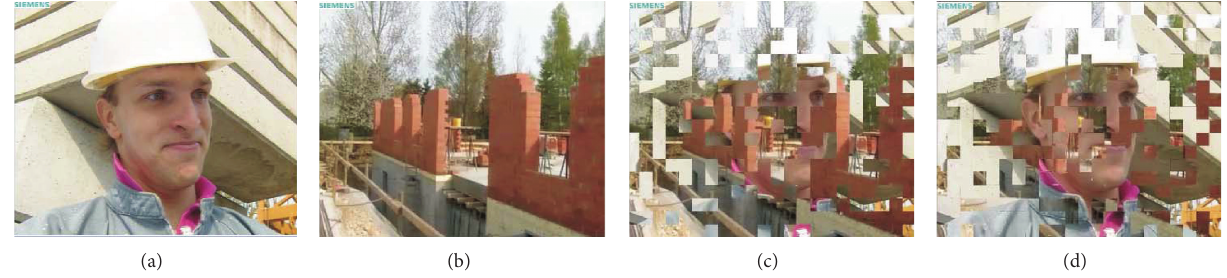
Figure 11: Frame reconstruction after a large burst: (a) original frame, (b) last frozen frame, and (c) (d) first and second reconstructed frames after the